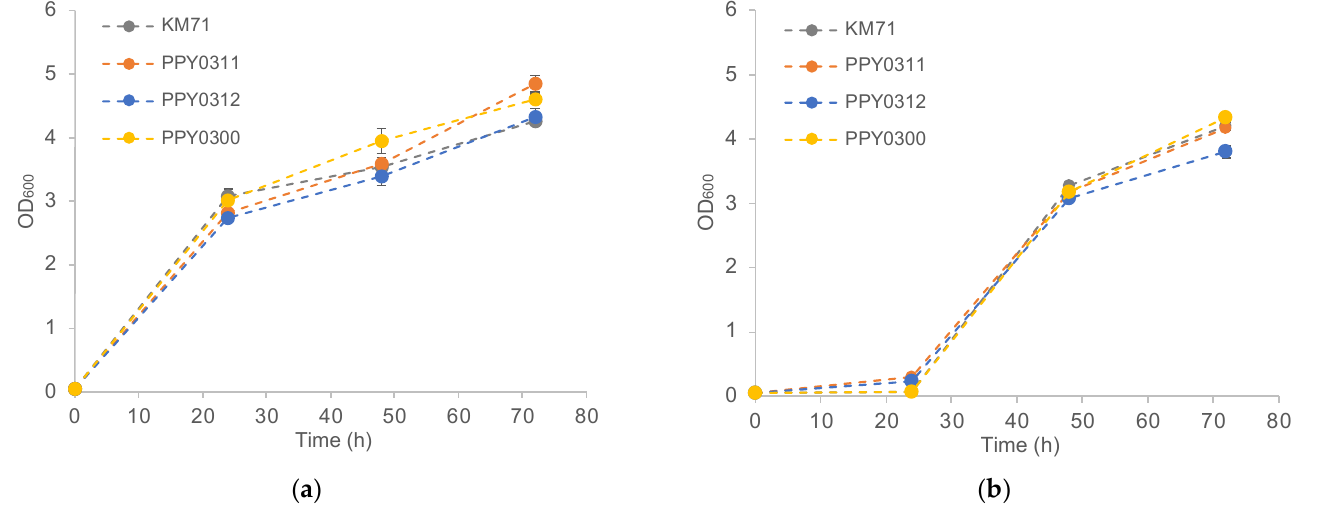
Figure 4. Growth profile of engineered P. pastoris strains in minimal medium containing different concentrations of sugarcane trash hydrolysates as the sole carbon source. ( a ) Growth in minimal medium with sugarcane trash hydrolysates with a total sugar content of 1.5%; ( b ) growth in minimal medium with sugarcane trash hydrolysates with a total sugar content of 2.0%.